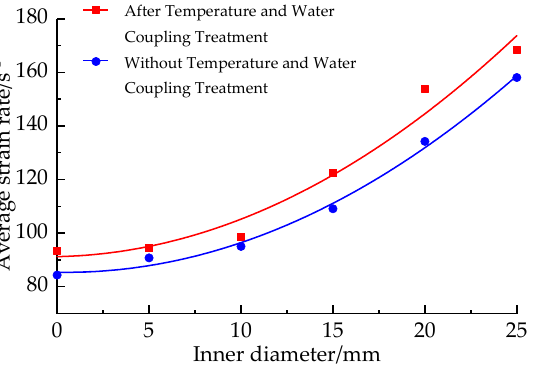
Figure 11. Diagram of average strain rate and annular diameter change.